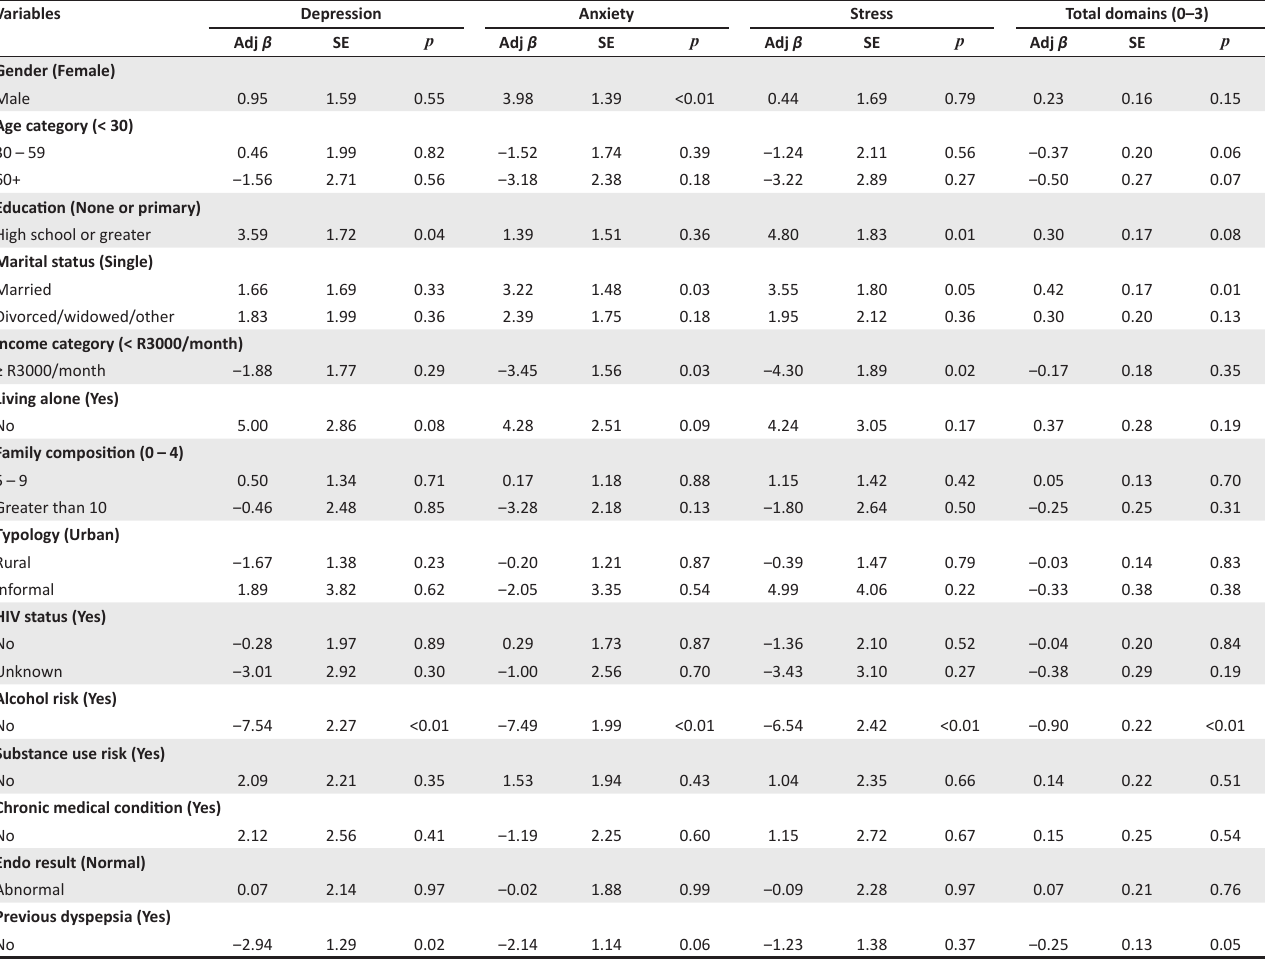
TABLE 3: Regression models investigating risk and protective correlates of depression, anxiety and